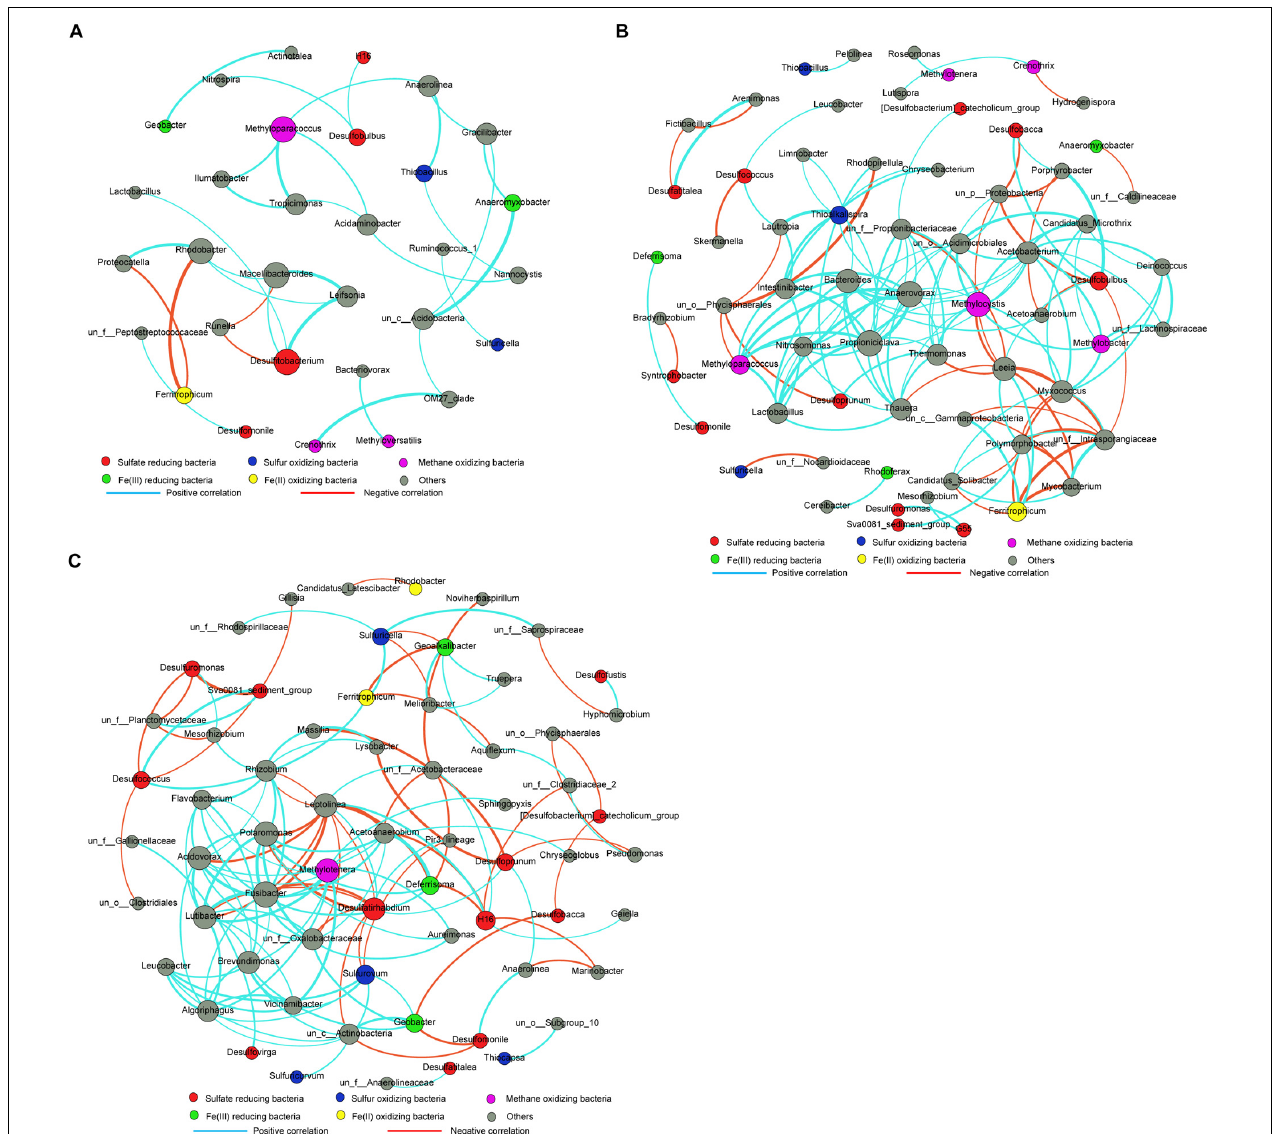
FIGURE 4 | Bacterial 16S rRNA genera-based correlation network for the sediments from RP (A) , RU (B) , and RA (C) . A node represents a genus. A connection stands for a strong (Spearman’s q > 0.9 or q < –0.9) and significant ( P < 0.01) correlation. Edge widths were scaled according to their weights and edge colors indicated a positive or negative correlation for the nodes they connect. The size of each node is proportional to the number of connections (the degree). n = 9 per group. un,